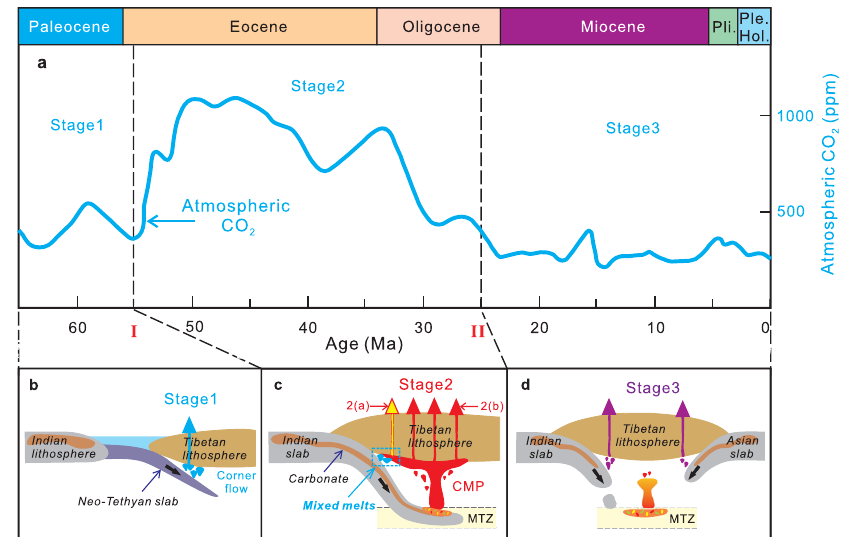
Fig. 2 Trilogy of plate subduction related to three-stage evolution of petrogenesis of collision-related Tibetan magmatism and global atmospheric CO 2 concentration variations in the Cenozoic. a Three-stage variations of atmospheric CO 2 concentrations in the Cenozoic. The data are from ref. 2 . b – d Three-stage evolution of the petrogenesis of collision-related Tibetan magmatism in the Cenozoic (see details in Supplementary Figs. 1 – 6). Neo-Tethyan oceanic lithosphere subduction in ( b ) resulted in corner fl ow and intermediate atmospheric CO 2 levels of Stage 1 (from 65 to 55 Ma) in ( a ). Indian continental lithosphere subduction in ( c ) resulted in a large-scale CMP upwelling and high atmospheric CO 2 concentrations of Stage 2 (from 55 to 25 Ma) in ( a ). India and Asia subduction in ( d ) resulted in a small-scale of opposing mantle convection and low atmospheric CO 2 levels of Stage 3 (from 25 to 0 Ma) in ( a ). The mixed melts in ( c ) denote a plume-wedge interaction in Stage 2(a) from 55 to 50 Ma. The black dashed lines labelled I and II denote the fi rst-step and second-step transformation of the mantle source region of the Tibetan magmas during the India-Asia collision (Supplementary Figs. 1 – 6), respectively. I: the fi rst-step transformation from Neo-Tethyan oceanic lithospheric subduction-induced silicate-rich metasomatism to India subduction- induced carbonate-rich metasomatism, II: the second-step transformation from India subduction-induced carbonate-rich metasomatism to dual India and Asia subduction-induced silicate-rich and carbonate-rich